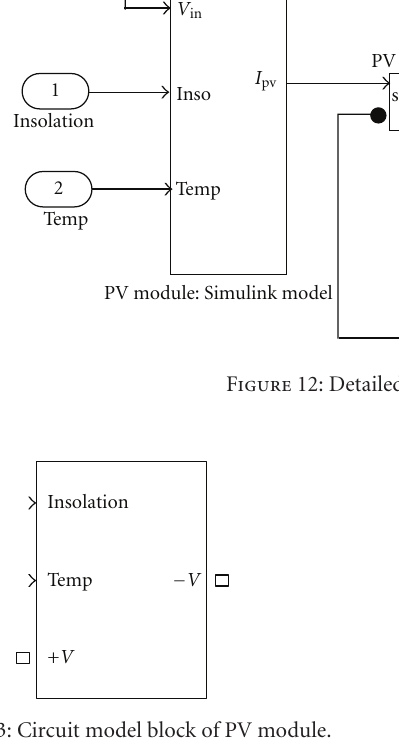
Figure 13: Circuit model block of PV